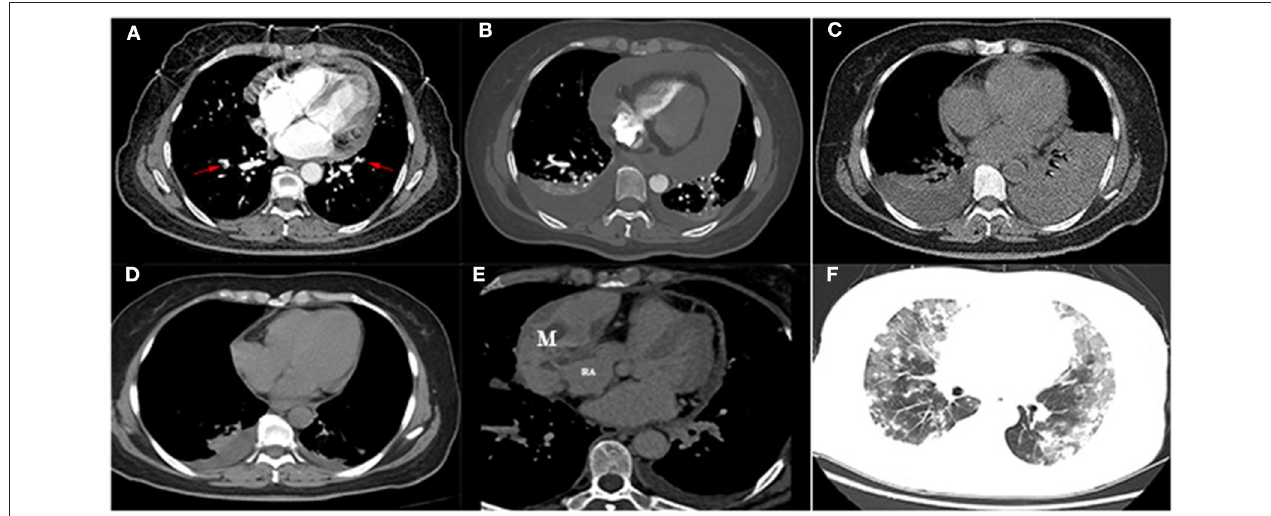
FIGURE 1 | (A) Computed tomography pulmonary angiography showed multiple embolisms of bilateral pulmonary arteries (arrow) with a mild-sized pericardial effusion. (B) Computed tomography showed a severe-sized pericardial effusion and bilateral pleural effusion after heparin anticoagulation. (C) The left pleural effusion was increased after pericardial drainage. (D) Computed tomography revealed mild bilateral pleural effusion and pericardial effusion after drainage. (E) Contrast-enhanced computer tomography showed a mixed mass located in the right pericardium (4.5 × 8.5cm), and the boundary was unclear between the mass and the right atrial wall, heterogeneous thickened pericardium, and moderate pericardial effusion locally. (F) Multiple metastatic nodules surrounded by a wide range of ground-glass-like effusion (diffuse alveolar hemorrhage) were identified in the bilateral lungs. M, mass; RA, right